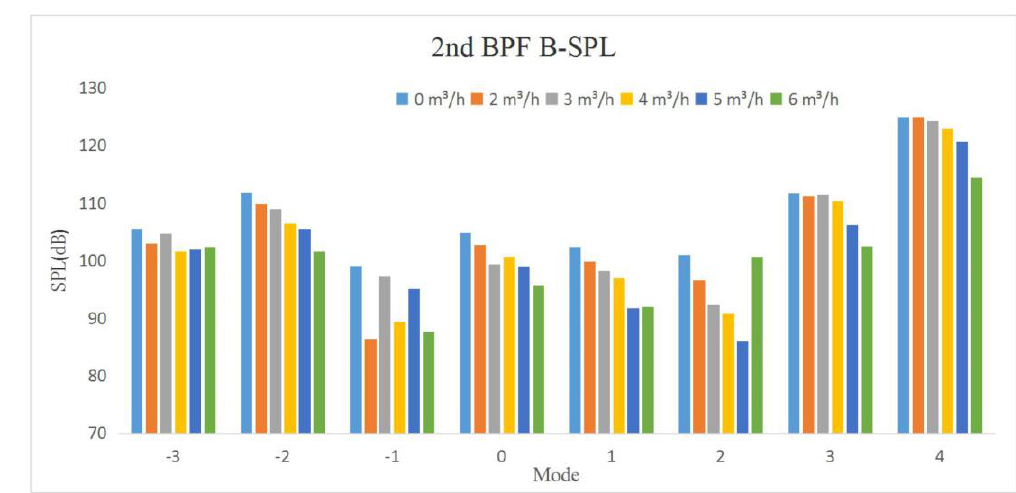
Figure 9. SPL of the first and second-order BPF.